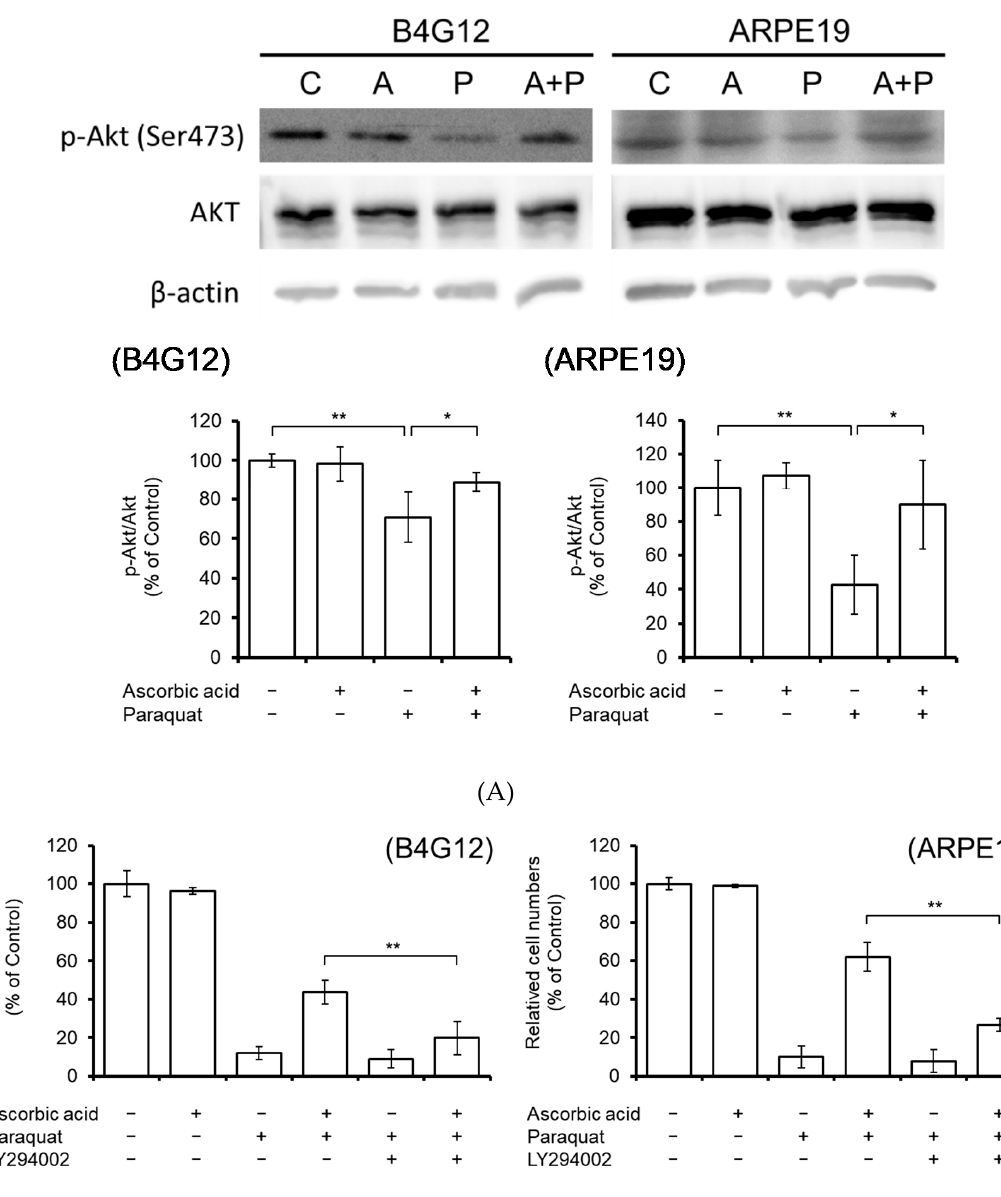
Figure Figure 4. The PI3K/AKT pathway is involved in ascorbic acid-mediated cell protection. ( A ) Phosphorylation of Akt (Bcl-2 upstream regulator) was detected by Western blotting. Total Akt and β -actin were used as loading controls. Paraquat-suppressed Akt phosphorylation was rescued by ascorbic acid. ( B ) To examine whether the PI3K/AKT pathway was involved in ascorbic acid- mediated cell protection, LY294002 (a PI3K inhibitor, 50 μ mol/L) was added in the culture medium. The cell protection effect was quantified by cell counting. Paraquat-induced cell loss was rescued by pretreatment with ascorbic acid, while the rescue effect of cell loss by ascorbic acid was significantly negated by the addition of LY294002. ( n = 3, * p < 0.05, ** p < 0.01).